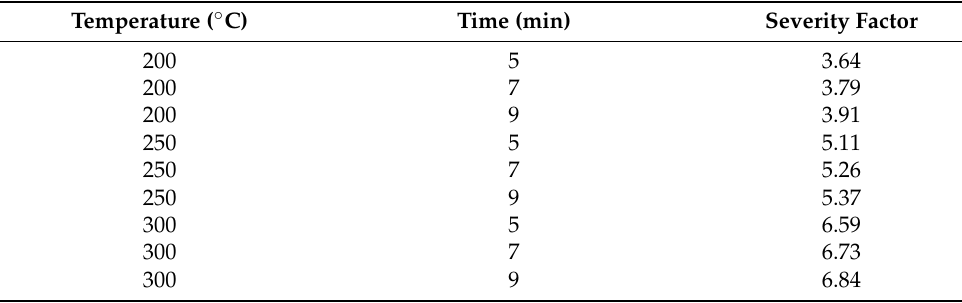
Table 3. Severity factor of microwave-assisted torrefaction of white spruce